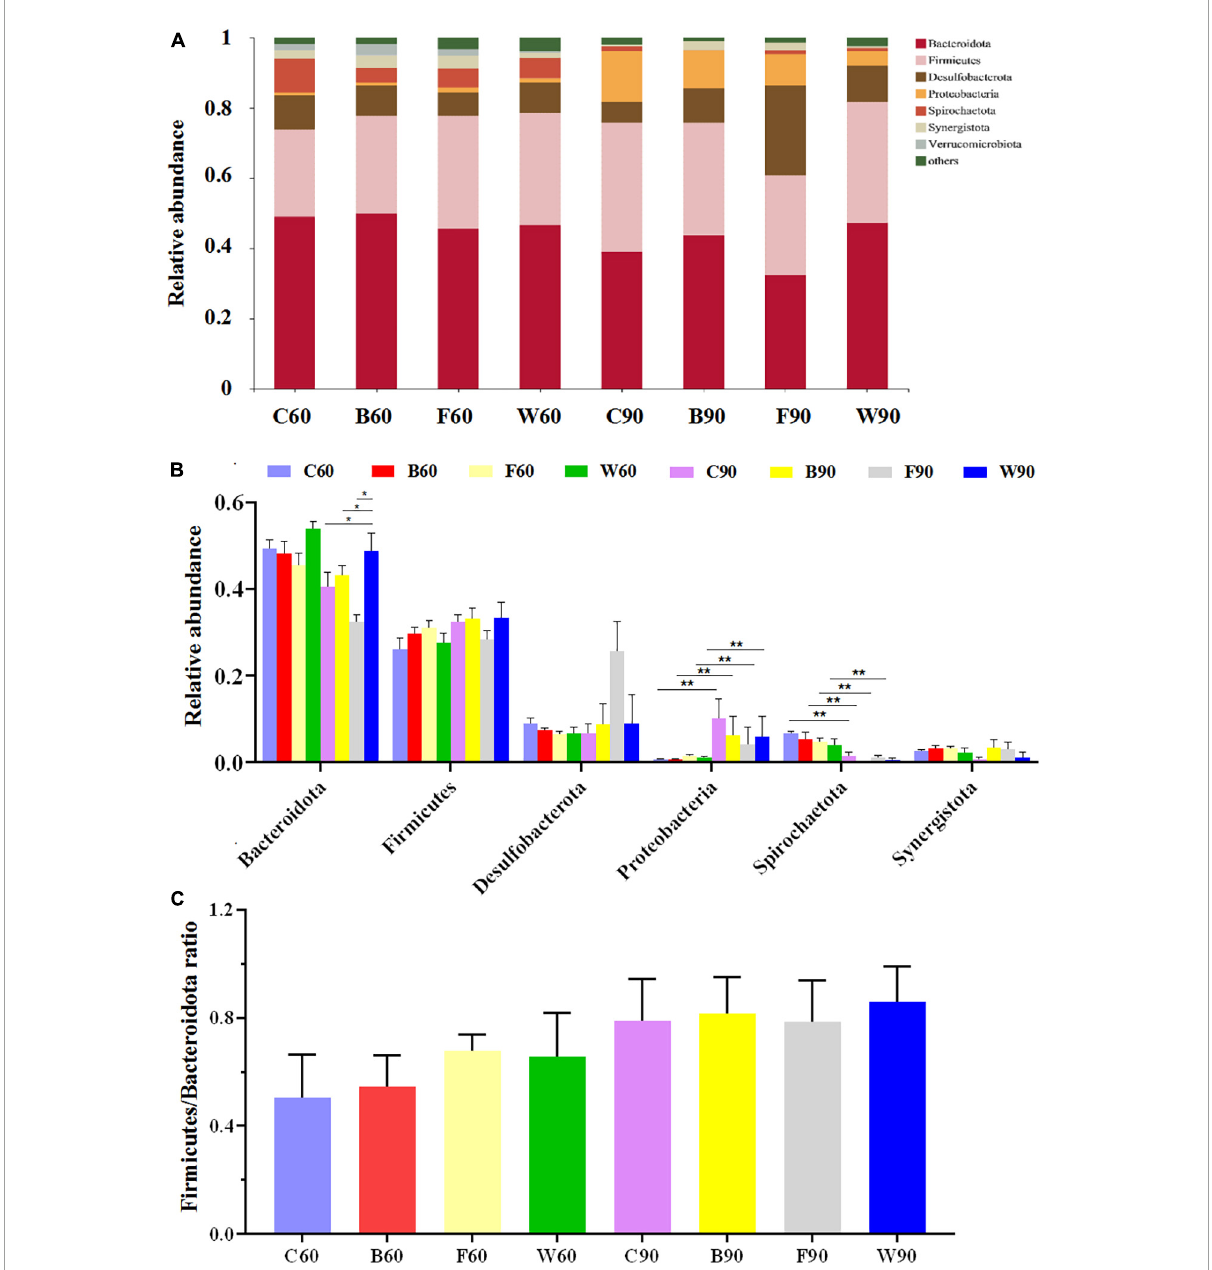
FIGURE2 The microbiome compositions in cecum at the phylum level based on the 16S rRNA sequencing in four groups of Landes geese (i.e., groups C, B, F, and W) on both days 60 and 90. (A) The relative abundances of the top seven bacterial phyla in the microbiome of Landes geese on days 60 and 90. (B) The relative abundances of top seven bacterial phyla among the four groups of Landes geese on days 60 and 90 showing the statistical significance. (C) The Firmicutes/Bacteroides (F/B) ratio in four groups of Landes geese on days 60 and 90. Values are represented as the mean ± stand error of the mean (SEM) ( n = 8 geese per group). The significant difference is set at P < 0.05 (*) and P < 0.01 (**), respectively. Group C, control group; Group B, added with 4% BSG in the overfeeding stage (days 61–90); Group F, added with 4% BSG in the rearing stage (days 5–60); Group W, added with 4% BSG in the all stage (days